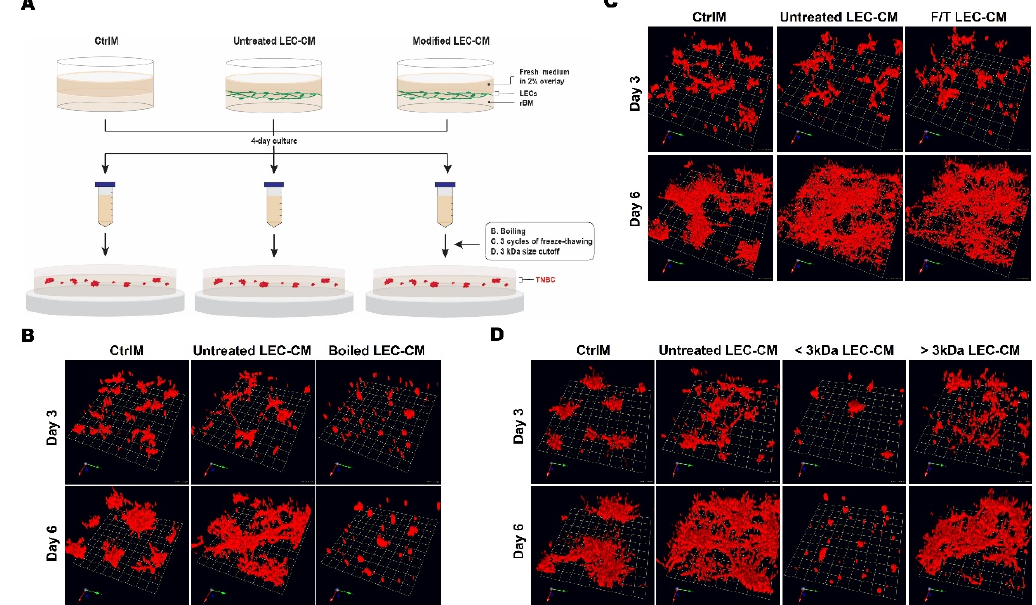
Figure 7. Effects of LEC secretome on increases in invasive outgrowths of 231 spheroids are retained following repeated freeze/thaw (F/T) cycles, but abolished by boiling, or by centrifugal ultrafiltration using filters for molecules less than 3 kDa in size. ( A ) Schematic illustrating protocol for incubation of 231 spheroids in 3D rBM overlay cultures with untreated or boiled, F/T, or 3 kDa cutoff LEC MG -conditioned media. ( B – D ) Angled images of 3D reconstructions of 231 spheroid monocultures (red) grown for 3 or 6 days in CtrlM, untreated LEC-CM, or LEC-CM subjected to boiling, 3 consecutive cycles of freezing and thawing, or centrifugal ultrafiltration using a 3 kDa cutoff filter. Images are tiled from 16 contiguous fields; each grid represents 170 µ